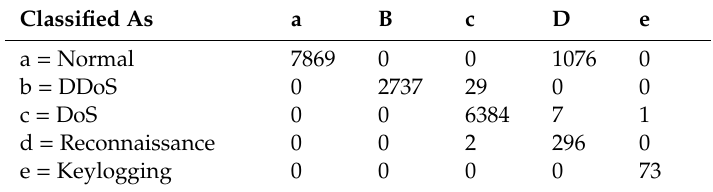
Table 12. Confusion matrix with the use of Hybrid classification.